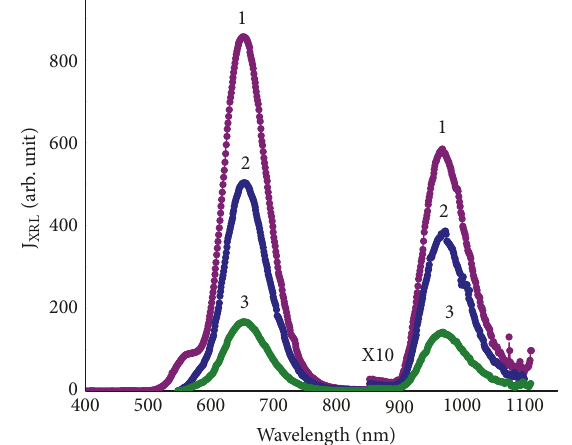
Figure 1: The distinctive XRL spectra of the ZnSe single crystal at the temperature of 8 K under different levels of excitation: the current of the X-ray tube, 25mA (1) ; 15mA (2) ; and 5mA (3) (the XRL intensity is multiplied by 10 for the 970 nm band).